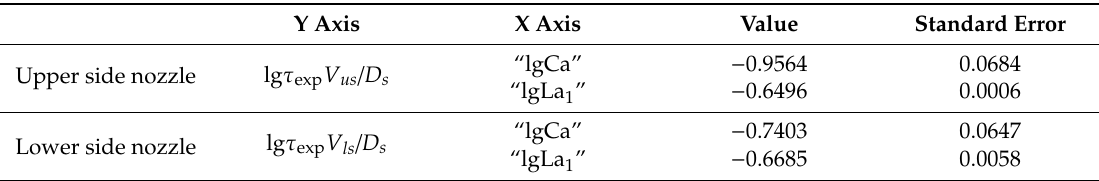
Table 6. Value and standard error of lg Ca and lg La 1 by multiple linear regression for the upper side nozzle and lower side